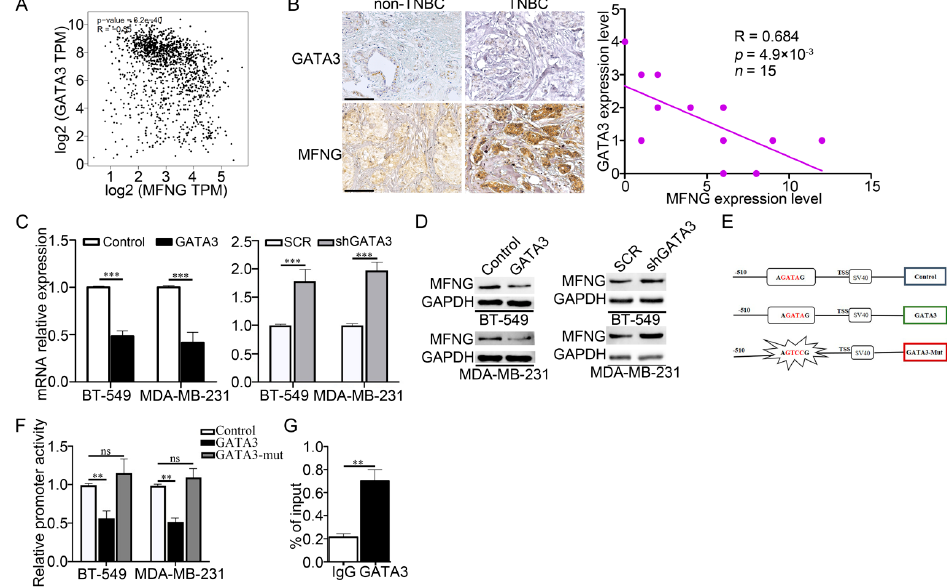
Figure 4. GATA3 negatively regulated MFNG transcription by abolishing its regulatory activity in TNBC. ( A ) Correlation analysis (GEPIA database) and IHC staining ( B ) revealed a negative correlation between the expression of GATA3 and MFNG in breast cancer, and statistical analysis in TNBC was shown, scale bar = 200 μ m. ( C ) RT ‐ qPCR and ( D ) Western blot analysis confirmed that MFNG was downregulated in GATA3 overexpressing or knockdown TNBC cells, SCR was short for Scram ‐ ble and GAPDH served as an internal control. ( E ) The constructed vectors with putative GATA3 binding site in the MFNG promoter region and the mutated binding site with their corresponding control. The luciferase ( F ) and ChIP ( G ) assays were performed to estimate the regulation of GATA3 on MFNG transcription in MDA ‐ MB ‐ 231 cells. Data were analyzed using a Student’s t ‐ test. All ** p < 0.01, *** p < 0.001, ns: not significant.